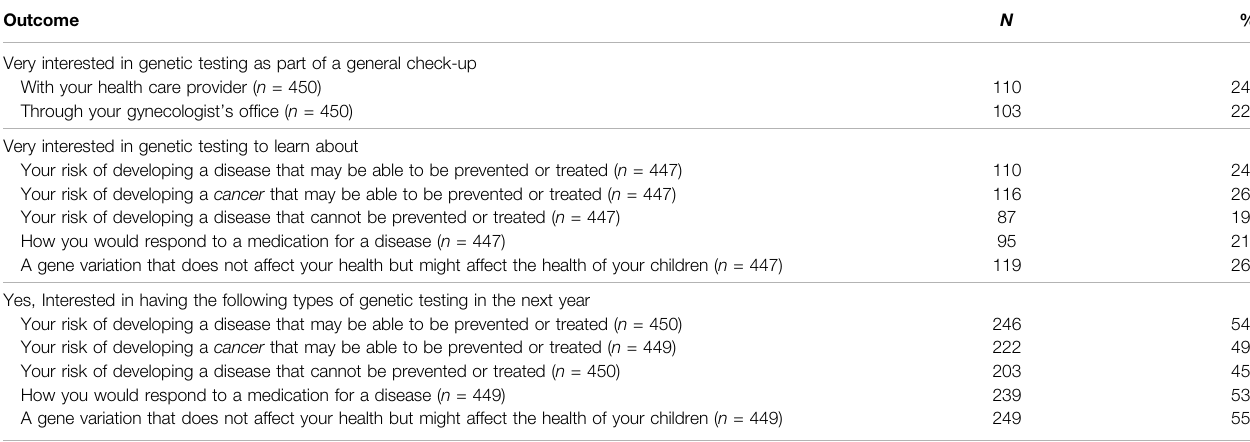
TABLE 3 | Interest in cancer predisposition testing and carrier screening among respondents ( n = 450). Outcome N %